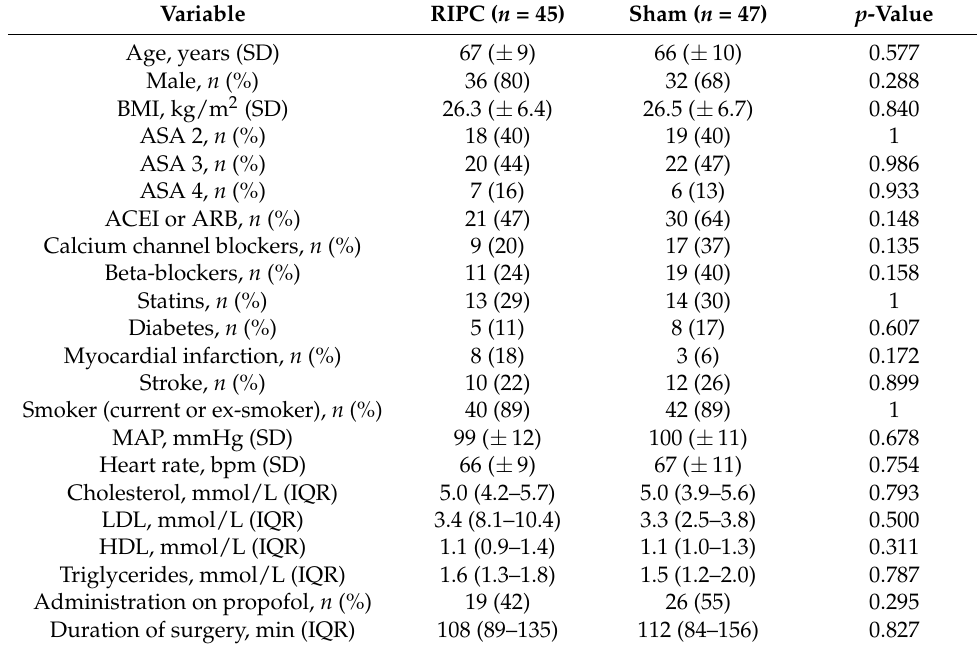
Table 1. Baseline characteristics.